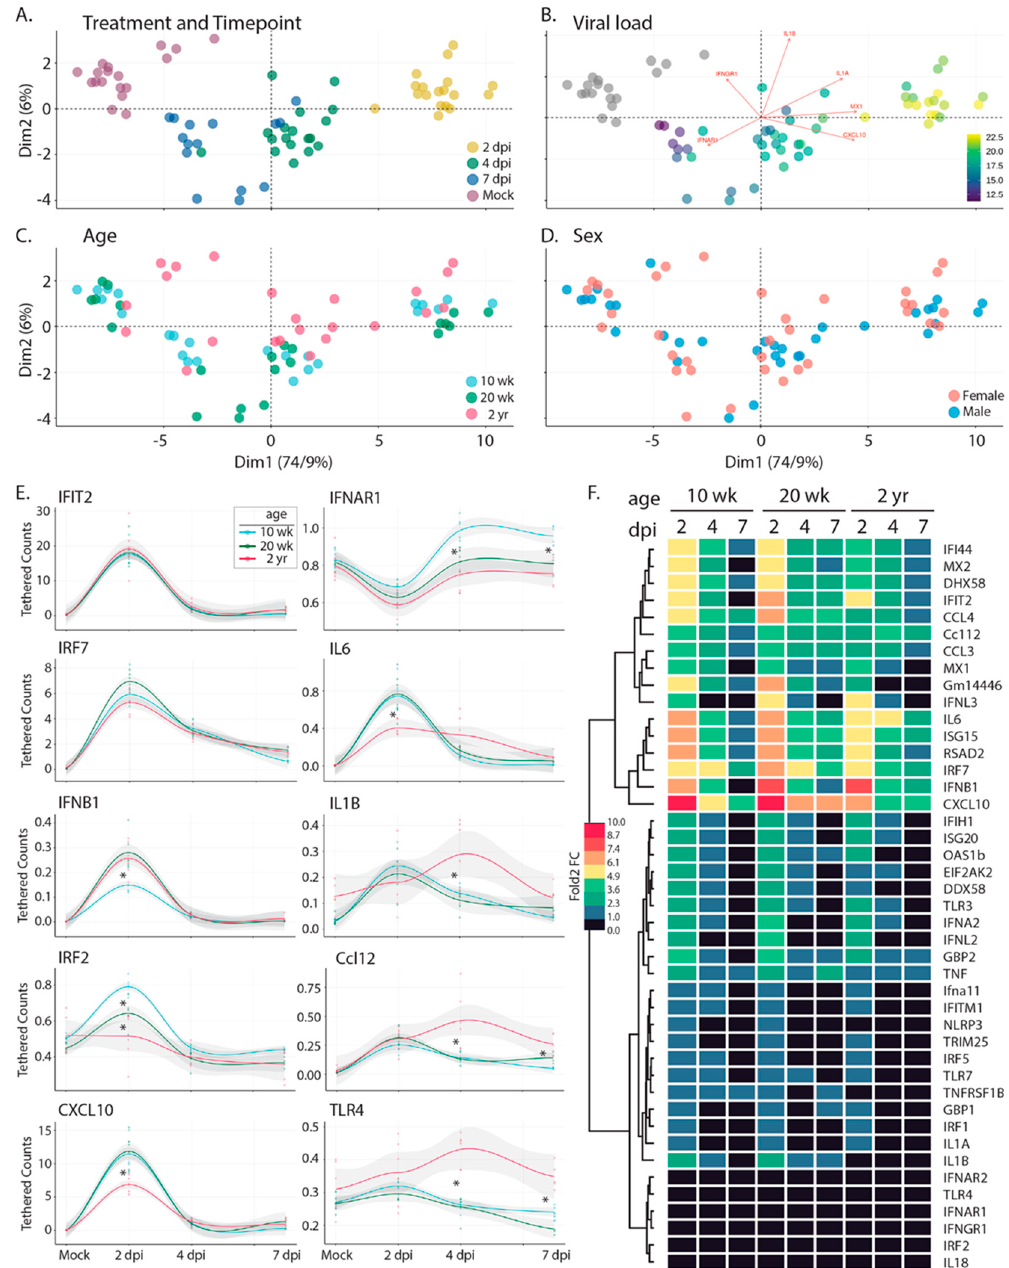
Figure 8. Bioinformatic analysis of the innate immune response following infection with R2G. Tissue was collected either 2, 4, or 7 days post infection or 7 days post mock infection from the 10 wk-, 20 wk-, and 2 yr-old male and female mice (Figure 4). Gene expression of 43 innate immune genes (Supplemental Table S8) was determined using the nCounter by NanoString. Raw expression and meta data can be found in Supplemental Tables S9 and S10, respectively. ( A – D ) PCA analysis of expression data for all mice overlaid with meta data for treatment and timepoint ( A ), viral load ( B ), age ( C ), and sex ( D ). Scree plots of eigenvalues of factors driving PC1 and PC2 can be found in Supplemental Figure S7. ( E ) Selected smoothed line plots for single gene expression data from 10 wk-, 20 wk-, and 2 yr-old mice for treatment and timepoint. Lines show smoothed average of tethered counts. Circles show individual animals. Grey shading shows 95% confidence interval. Asterisks mark significant differences as determined by Tukey’s adjustment for multiple comparisons where * is p ≤ 0.05 (see Supplemental Figure S7). Plots for all genes analyzed can be found in Supplemental Figure S10. ( F ) Heat map showing log 2-fold change gene expression relative to mock treated controls.